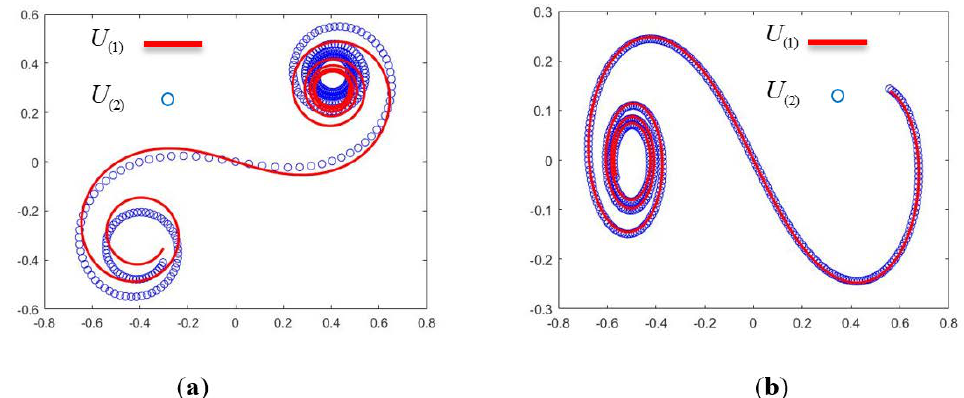
Figure 4. The complex plane plot of U ( 1 ) and U ( 2 ) : ( a ) z = 0.1 µ m (Zone 1); and ( b ) z = 2.5 µ m (Zone 2).